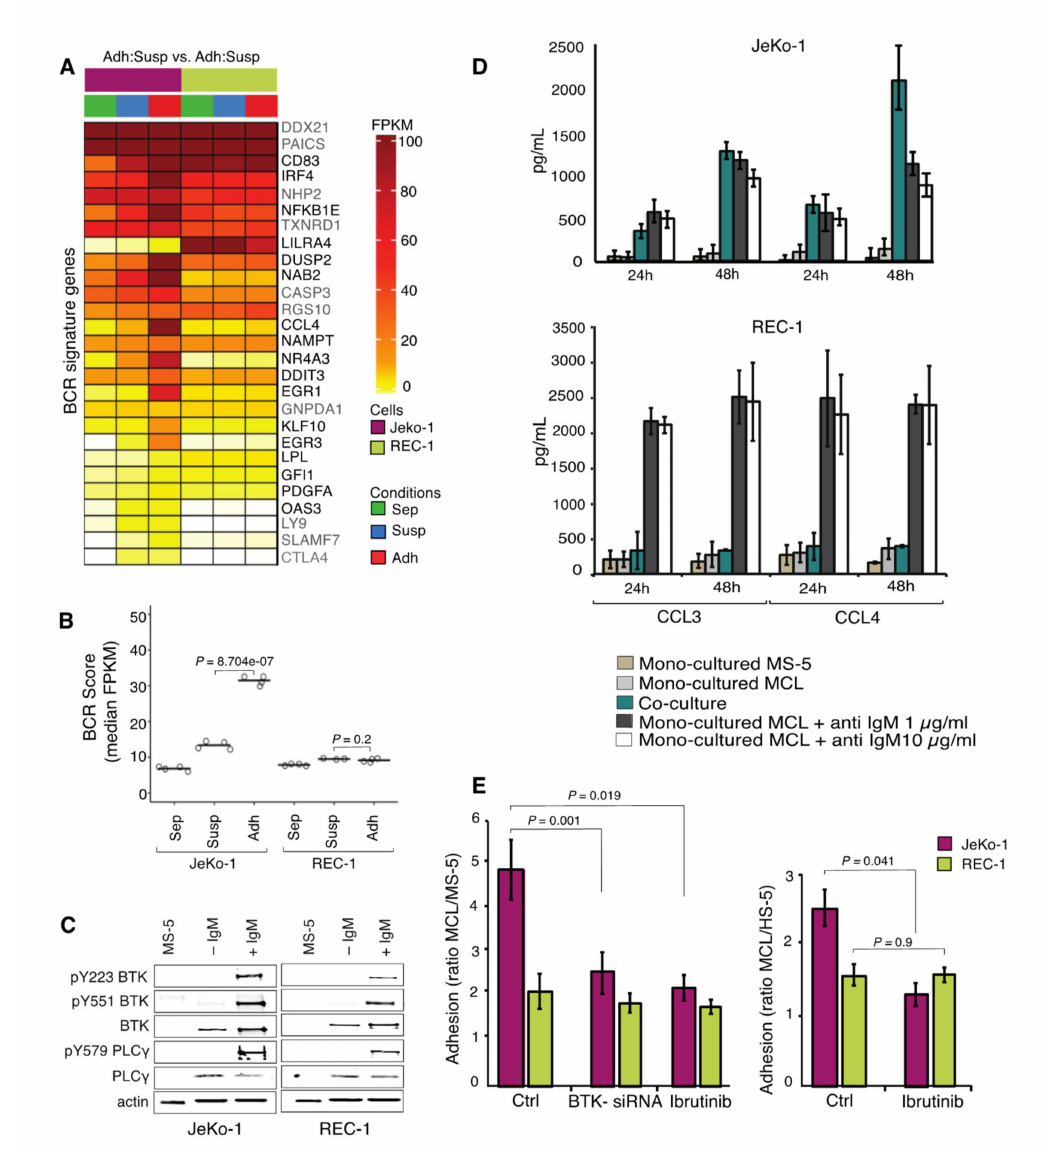
Figure 4. Di ff erential expression di ff erences in B-cell receptor (BCR) signature genes in JeKo-1 and REC-1 cells upon adhesion to stroma. ( A ) Transcript levels for BCR signature genes for three di ff erent fractions of JeKo-1 and REC-1 cells, monocultured cells (Sep, in green), suspension cells in coculture (Susp,